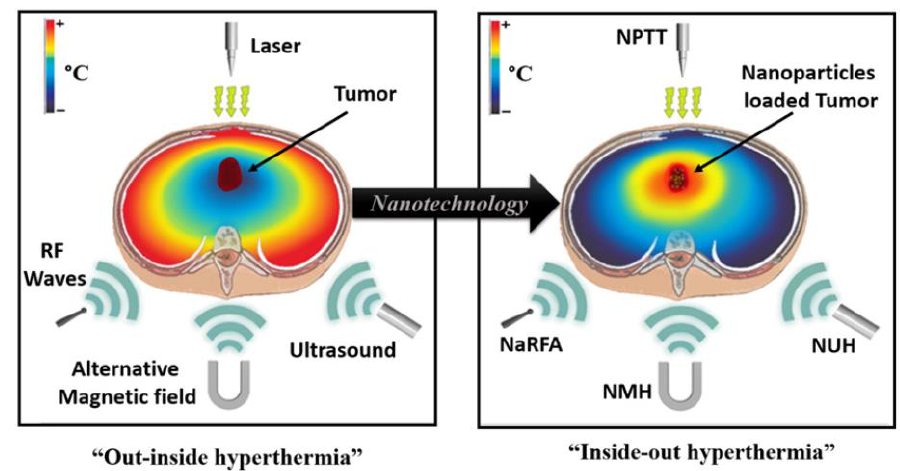
Figure 3. Thermal hypothermia of a tumor using nanoparticles enclosed inside of it absorbing the energy coming from di ff erent heat sources. NPTT—Nano-Photothermal Therapy, NMH—Nano-Magnetic Hyperthermia, NaRFA—Nano-Radio-Frequency Ablation, NUH—Nano-Ultrasound Hyperthermia [Reproduced from [8], with permission from Elsevier, Copyright